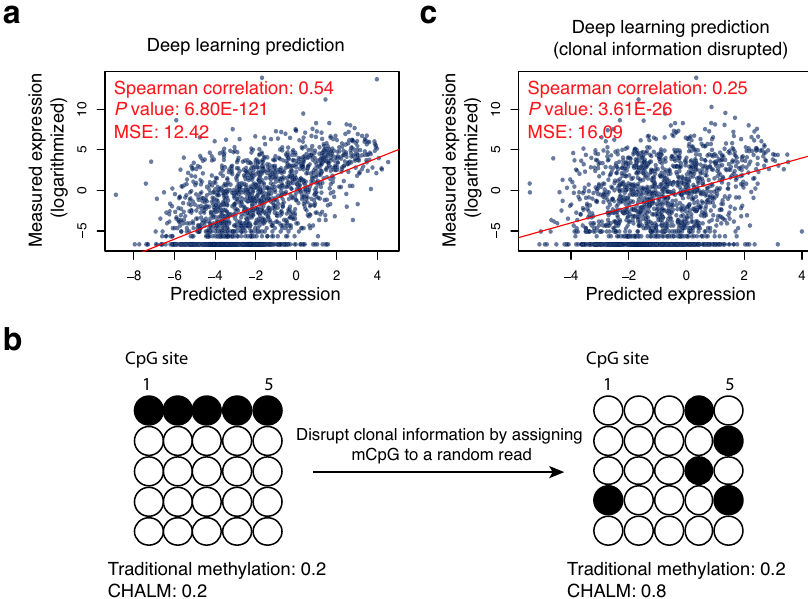
Fig. 3 Clonal information is crucial for gene expression prediction. a Prediction of gene expression based on raw bisul fi te sequencing reads via a deep- learning framework. b Disruption of read clonal information by shuf fl ing the mCpGs among mapped reads. c The clonal information is disrupted before prediction. Comparison of correlation (between prediction models with and without clonal information disrupted) permutation P values: <1 × 10 − 4